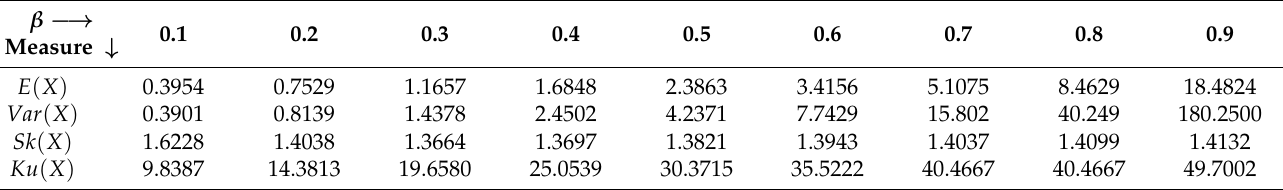
Table 1. Some CS of the DMEx distribution.